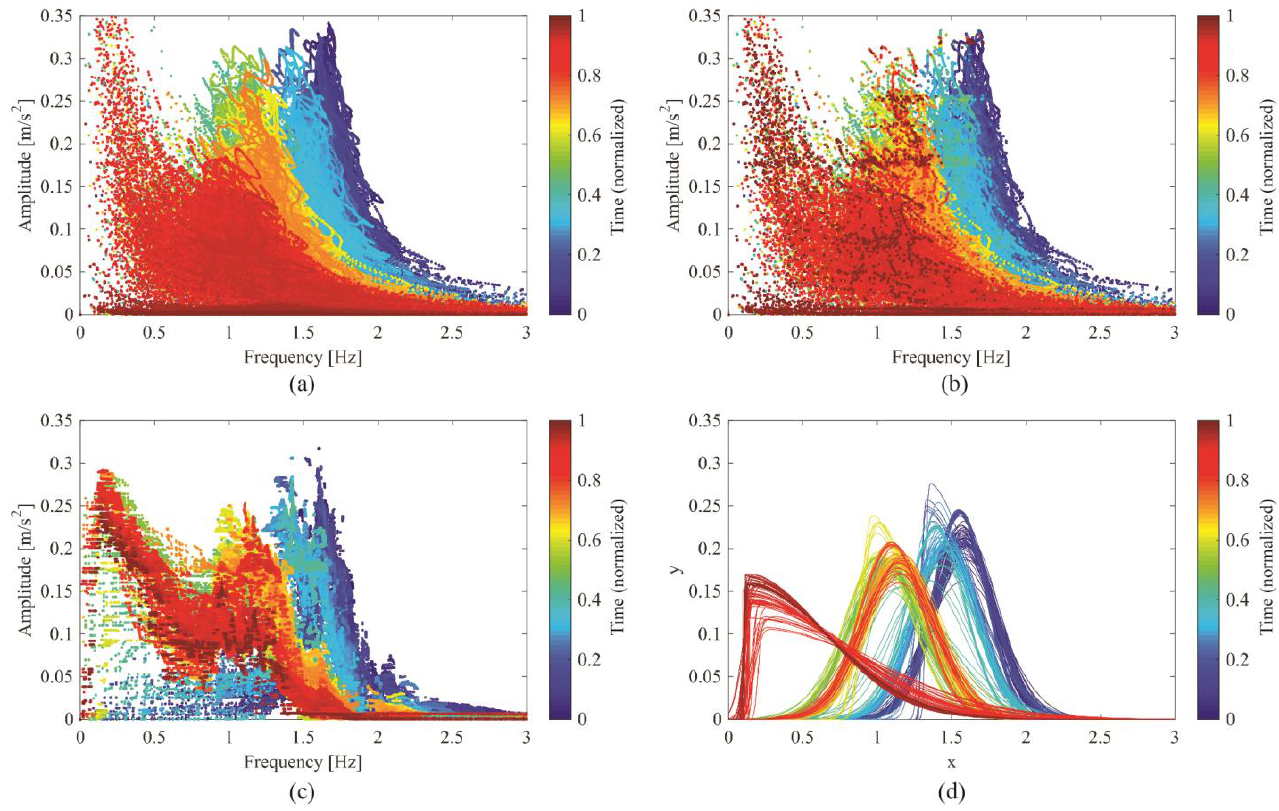
Figure 5. Model identification process: ( a ) original set of identified parameters, ( b ) reorganized sets, ( c ) filtered set, and ( d ) models identified from filtered data.